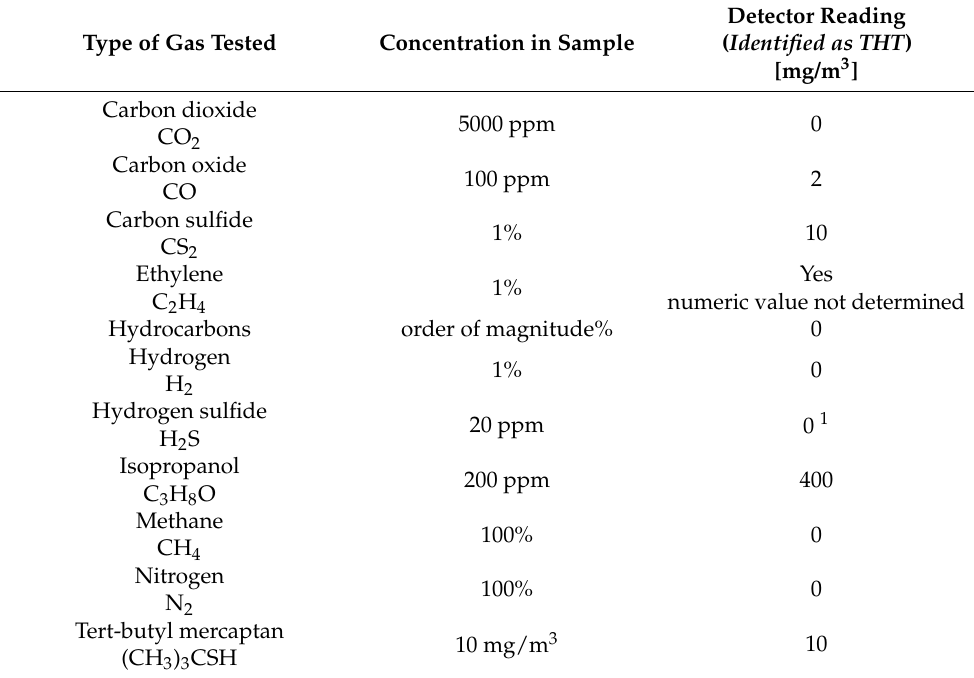
Table 2. Cross-sensitivity to gaseous pollutants at a temperature of 20 ◦ C—as declared by a THT detector manufacturer